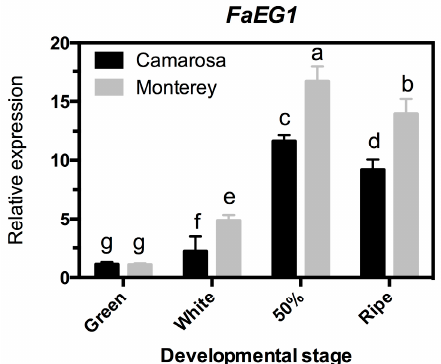
Figure 2. Changes in FaEG1 mRNA levels measured by reverse-transcription quantitative polymerase chain reaction (RT-qPCR) during fruit development and ripening of the di ff erent strawberry ( Fragaria x ananassa ) cultivars. The expression data of the FaEG1 correspond to the mean of three replicates normalized against FaGADPH1 abundance. Di ff erent letters indicate significant di ff erences between cultivars and stages ( P < 0.05).